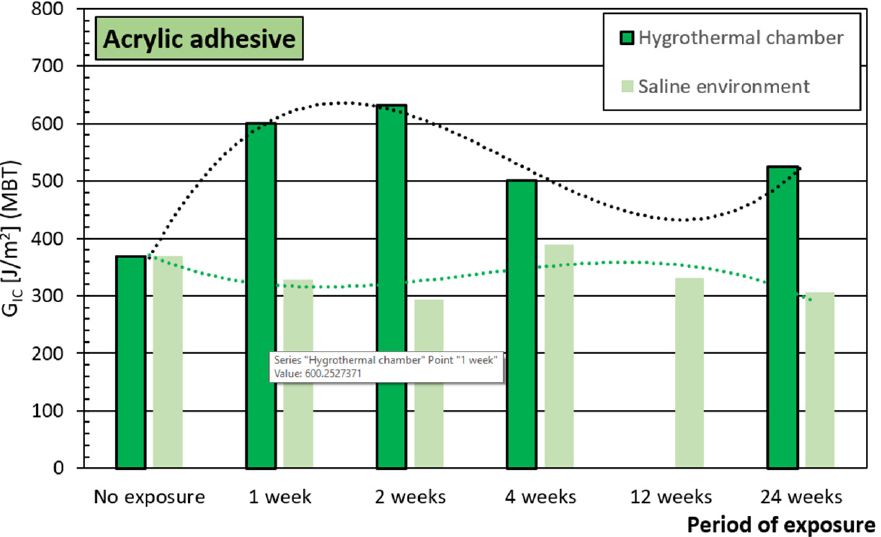
Figure 10. Energy release rate evolution under mode I of the acrylic adhesive, comparison between saline and hygrothermal stresses.